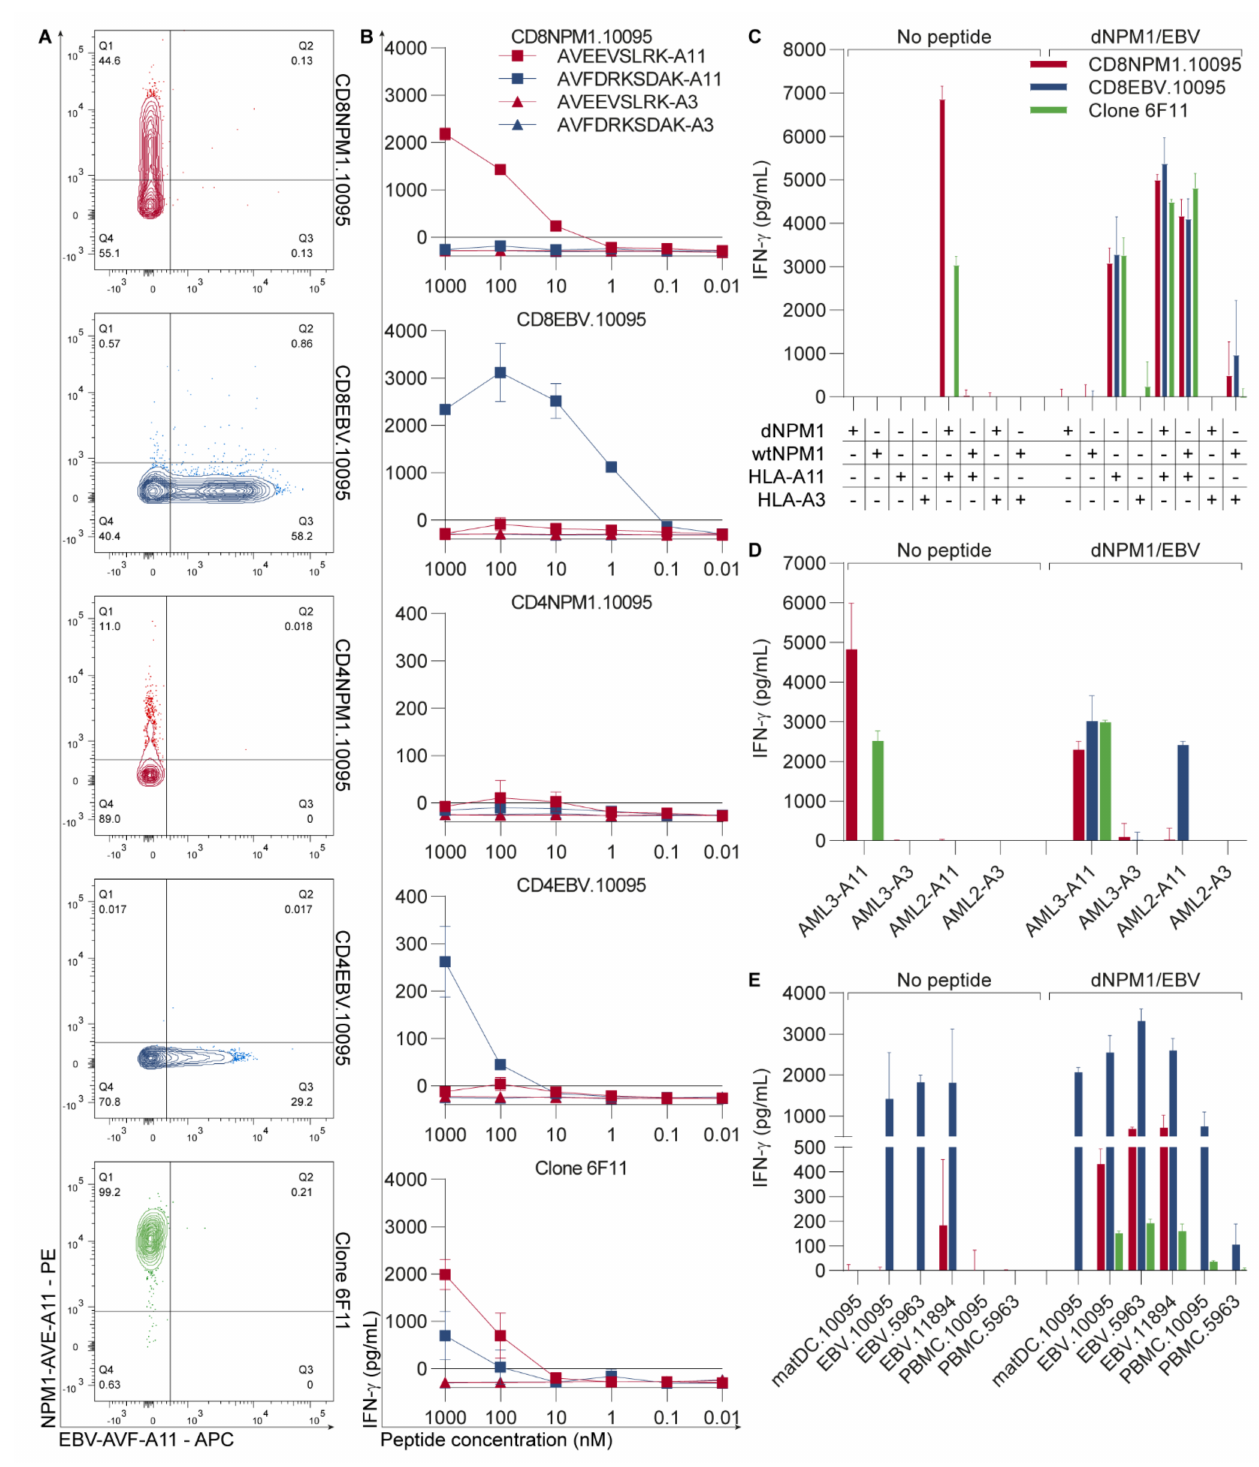
Figure 2. dNPM1-derived AVEEVSLRK in HLA-A11 can be targeted by TCR gene transfer. PBMCs from two HLA- A11+ healthy individuals (donors 10095 and 5963) were transduced with the TCR from clone 6F11 recognizing dNPM1 AVEEVSLRK in HLA-A11 and a control TCR for EBV AVFDRKSDAK in HLA-A11. The TCR-transduced CD8 and CD4 T-cells were sorted by FACS, stimulated and tested after 10–13 days. T-cells were incubated overnight with stimulator cells at an E:S ratio of 1:7.5 and IFN- γ secretion was measured by ELISA. In ( C – E ), stimulator cells were also pulsed with a mix of dNPM1 and EBV peptides at a concentration of 500 nM per peptide. Results are shown for donor 10095. Results for donor 5963 are shown in Figure S3. ( A ) Purity of TCR-transduced T-cells was assessed by flow cytometry using antibodies against CD8 and CD4 and pHLA-tetramers. Staining with the NPM1-AVE-A11 tetramer was observed for 44.6% of CD8 and